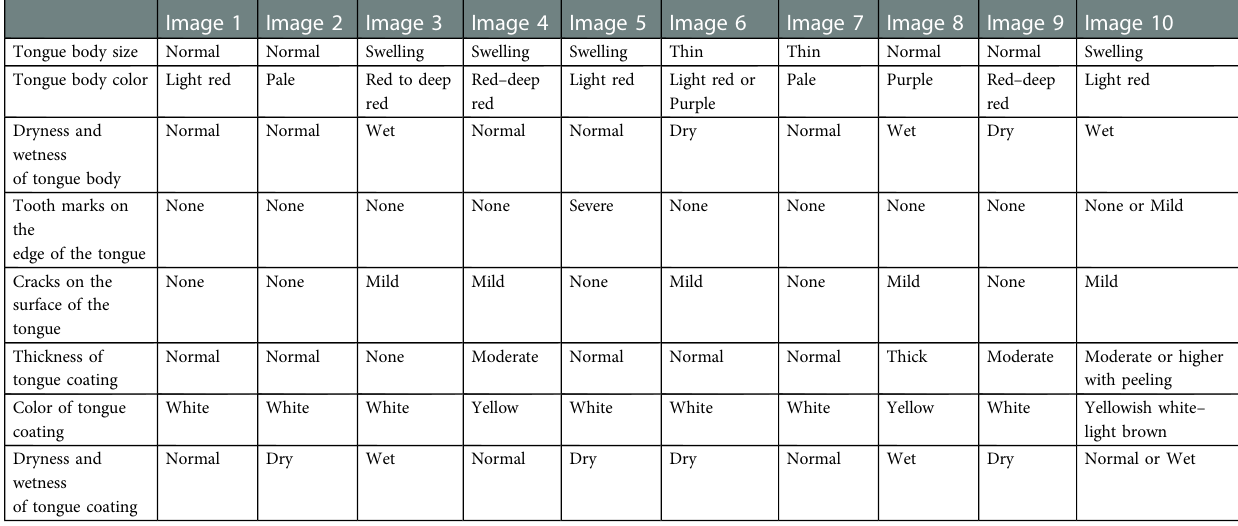
TABLE 1 Answer of the 80-question tongue diagnosis test determined by 15 KSs (Study